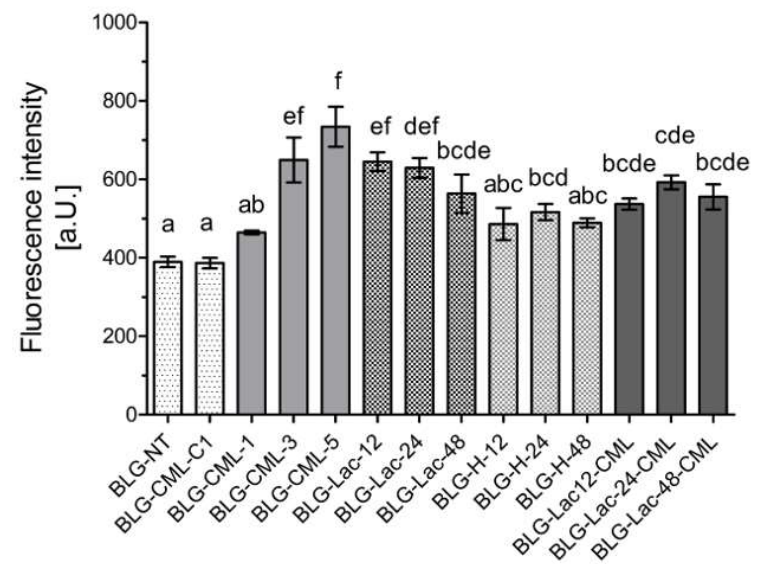
Figure 3. Thioflavin-T assay of β-lactoglobulin (BLG), non-treated (NT), control for chemical modification (C1), chemically modified BLG to introduce N ɛ -carboxymethyl lysine (CML) at different levels of CML, glycated with lactose (Lac) by heating at 60 °C for 12, 24, and 48 hours; heated at 60 °C for 12, 24, and 48 hours in the absence of any sugars (H), and glycated by heating with lactose followed by CML induction with glyoxal. Fluorescence intensity was corrected for the autofluorescence of the samples and fluorescence of the blank. Significant differences were tested using one-way ANOVA with Tukey post-hoc test, considered as significant at p < 0.05 between technical replicates ( n = 2), where two variables have different letters if they are significantly different.